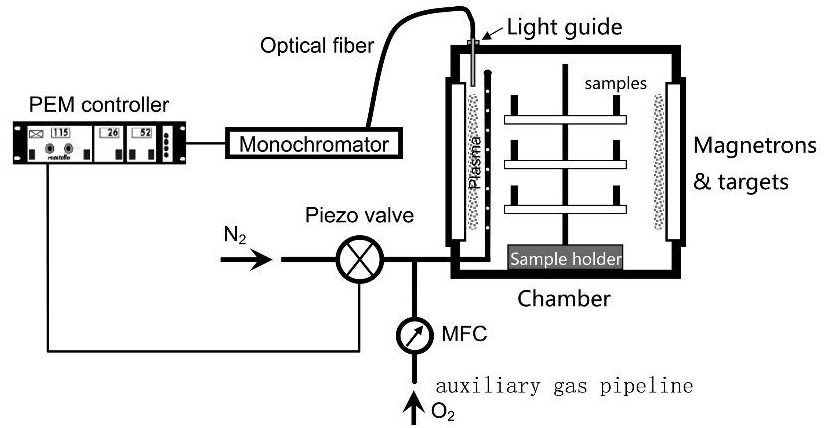
Figure 2. Schematic diagram of the setup of the plasma emission monitor (PEM)-controlled dual-gas reactive direct current magnetron sputtering ( dc MS) system [8].